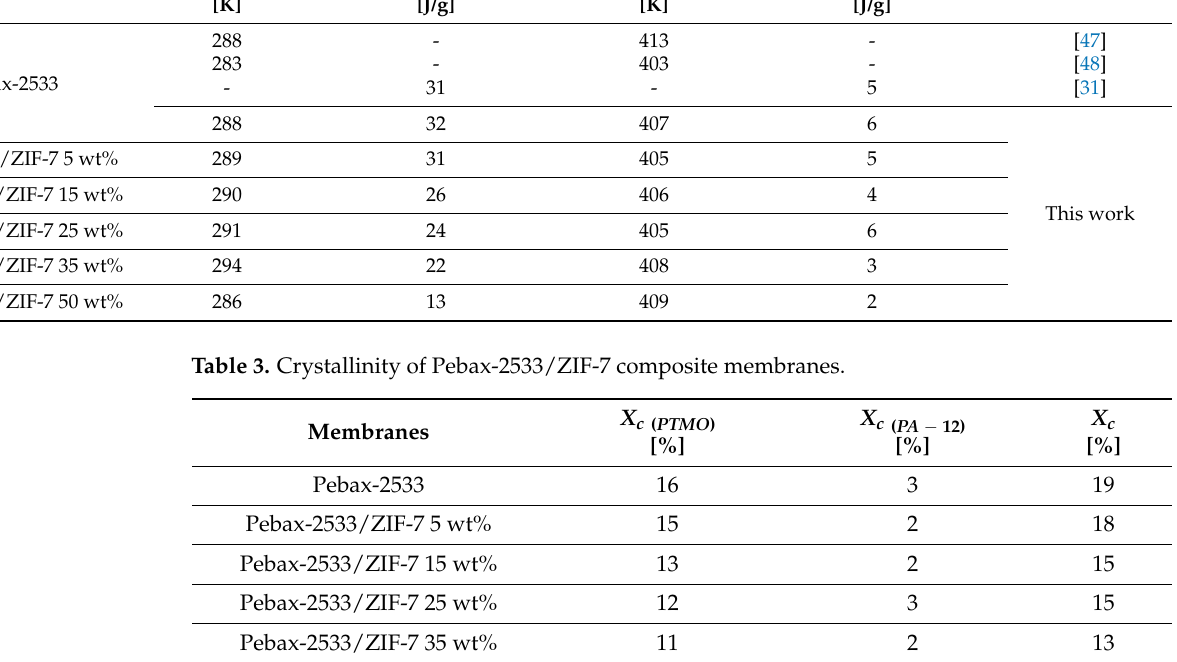
Table 2. Melting temperature and melting enthalpy of Pebax ‐ 2533/ZIF ‐ 7 composite membranes.